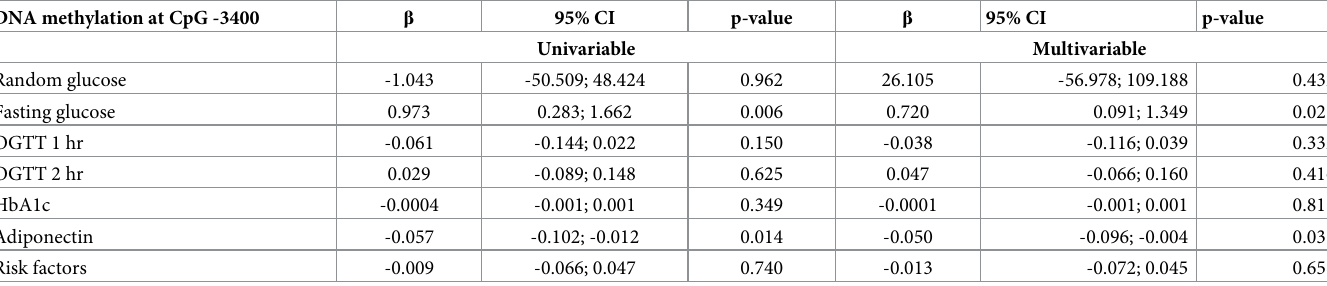
Univariable linear regression analysis: DNA methylation and clinical parameters.